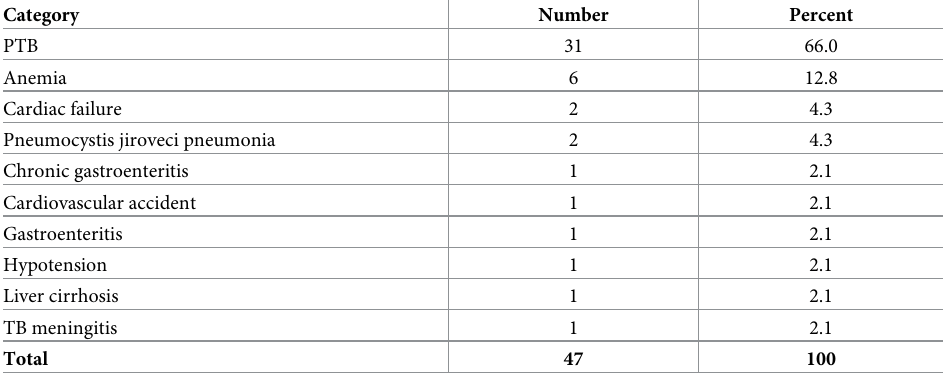
Table 6. Likely causes of death among persons with TB in Itezhi-Tezhi District as recorded on death certificate (2015–2018), n =